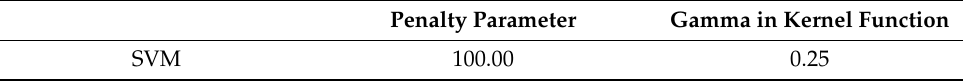
Table 3. The parameter used for